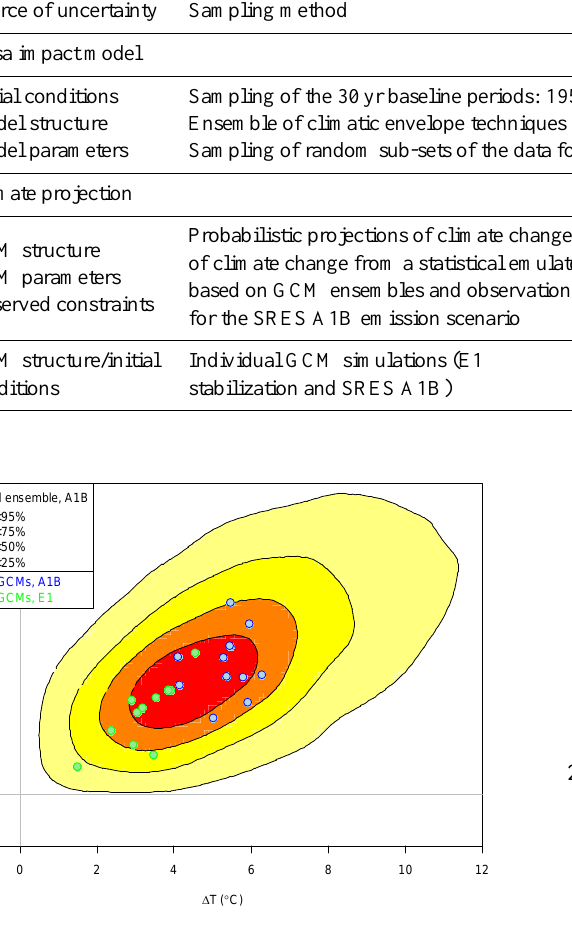
Fig. 3. Changes from 1961-1990 to 2080–2099 in annual mean Figure 3. Changes from 1961–1990 to 2080–2100 in annual mean temperature (°C) and temperature ( ◦ C) and precipitation (%) over northern Lapland for precipitation (%) over northern Lapland for the Grand Ensemble probabilistic projection the Grand Ensemble probabilistic projection (Harris et al., 2010) (Harris et al., 2010) and an ensemble of GCM simulations for the E1 mitigation and SRES and an ensemble of GCM simulations for the E1 mitigation and A1B scenarios (Johns et al., 2011). Probabilities are depicted as the percentage of projections SRES A1B scenarios (Johns et al., 2011). Probabilities are depicted enclosed within coloured zones. as the percentage of projections enclosed within coloured